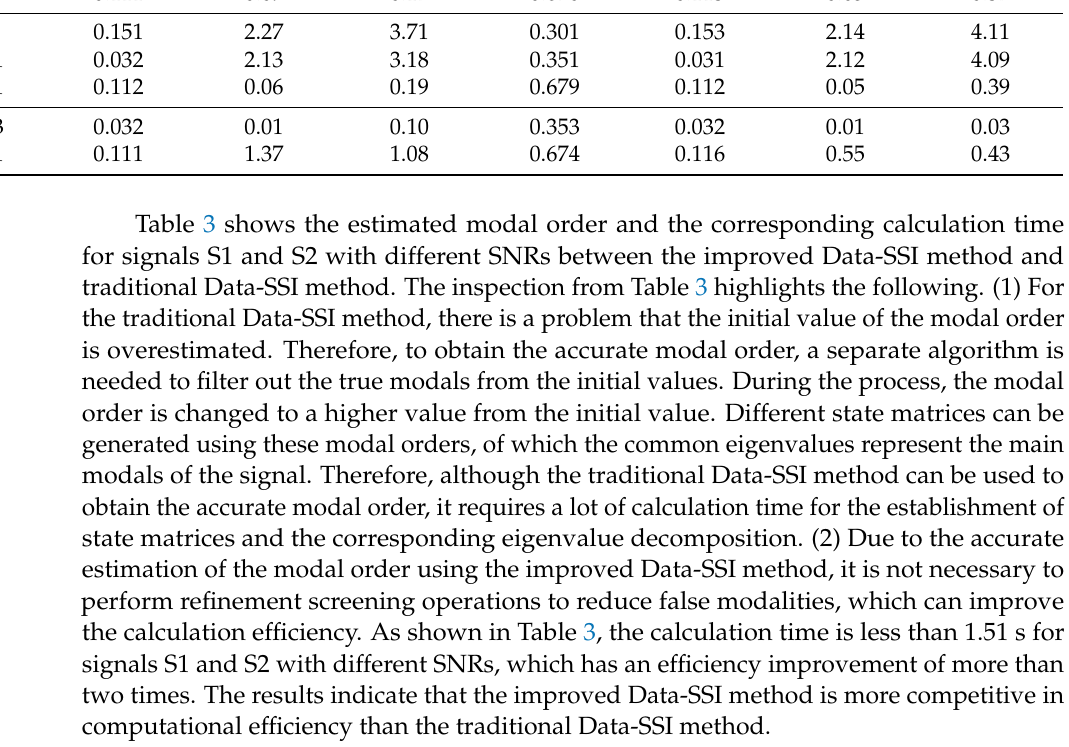
Table 3. Comparison of the computation time and modal order between the improved Data-SSI method and the traditional SSI